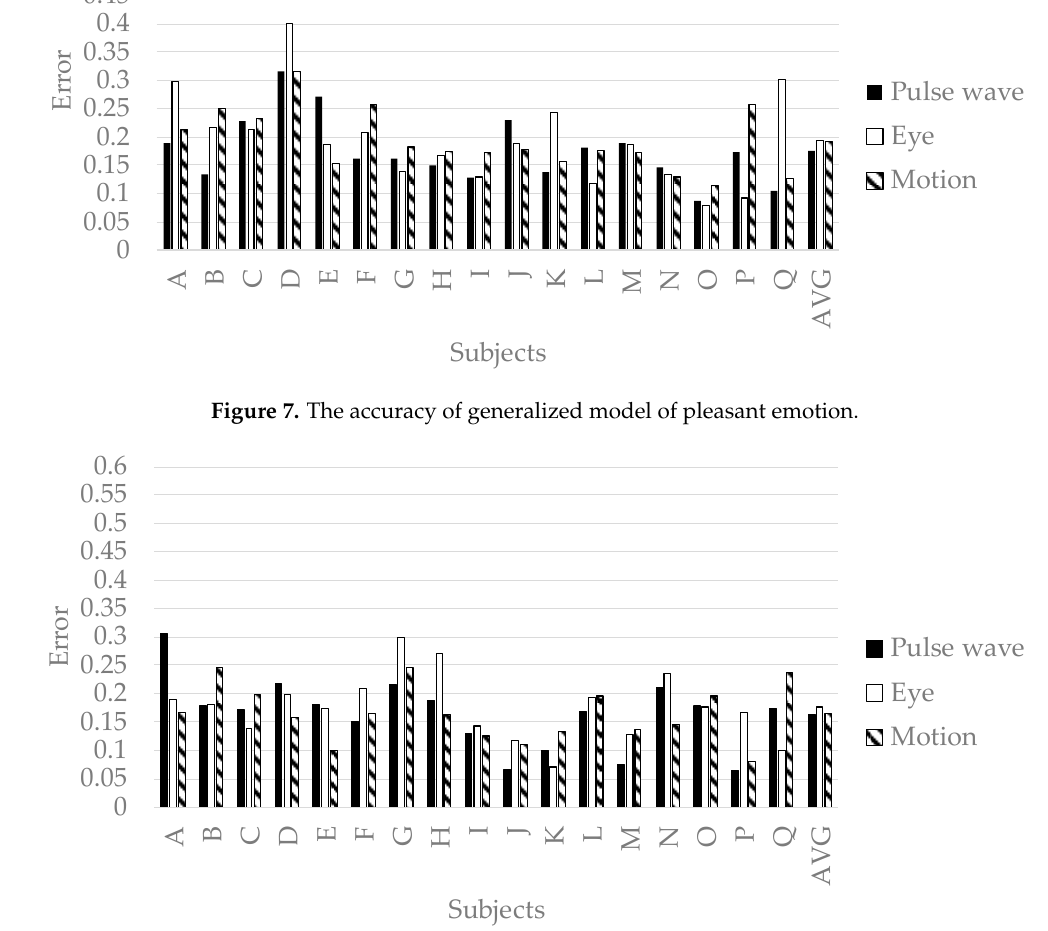
Figure 8. The accuracy of generalized prediction model of arousal.